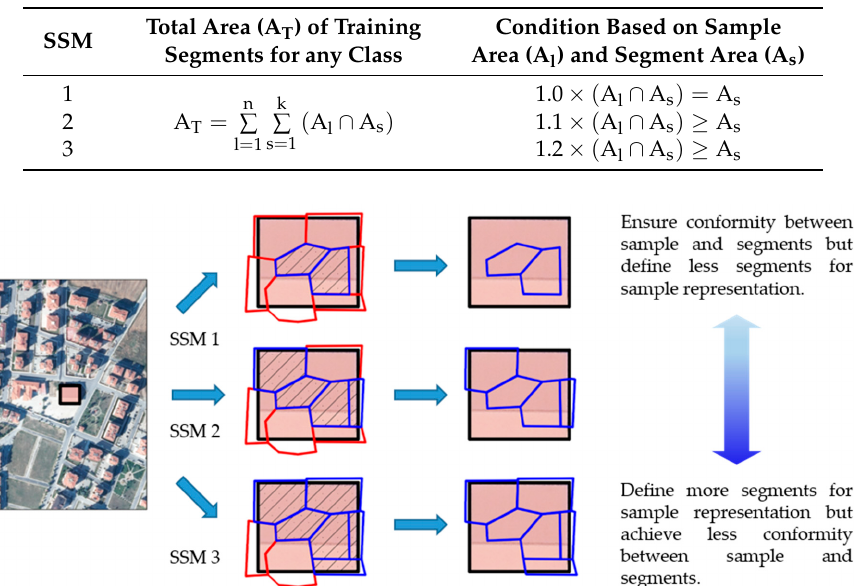
Figure 6. Defining training segments using different criteria.